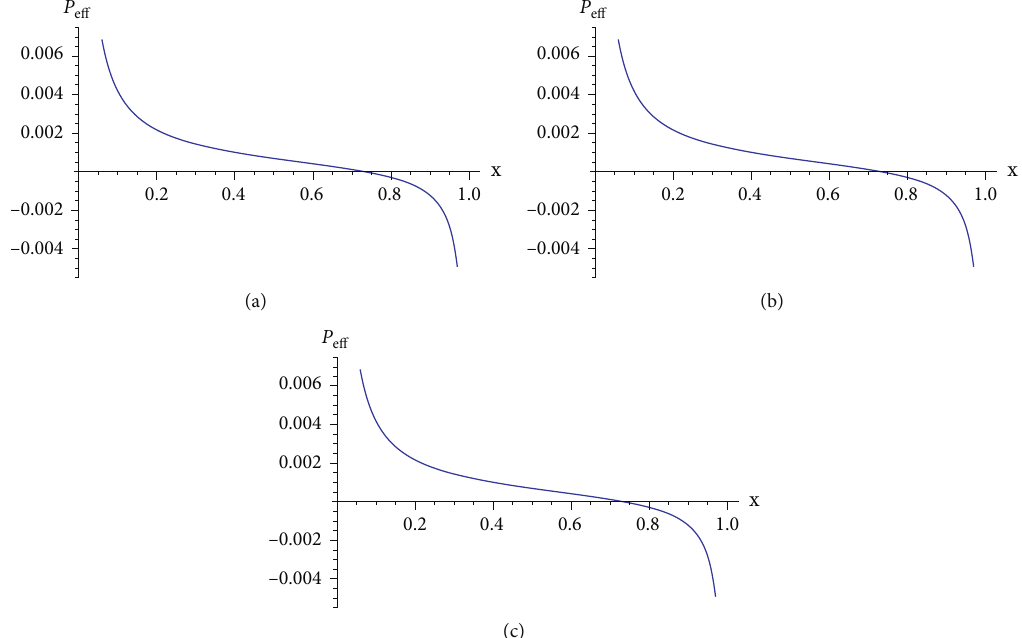
= 0 : 04 , and (c) for ϕ 2 +